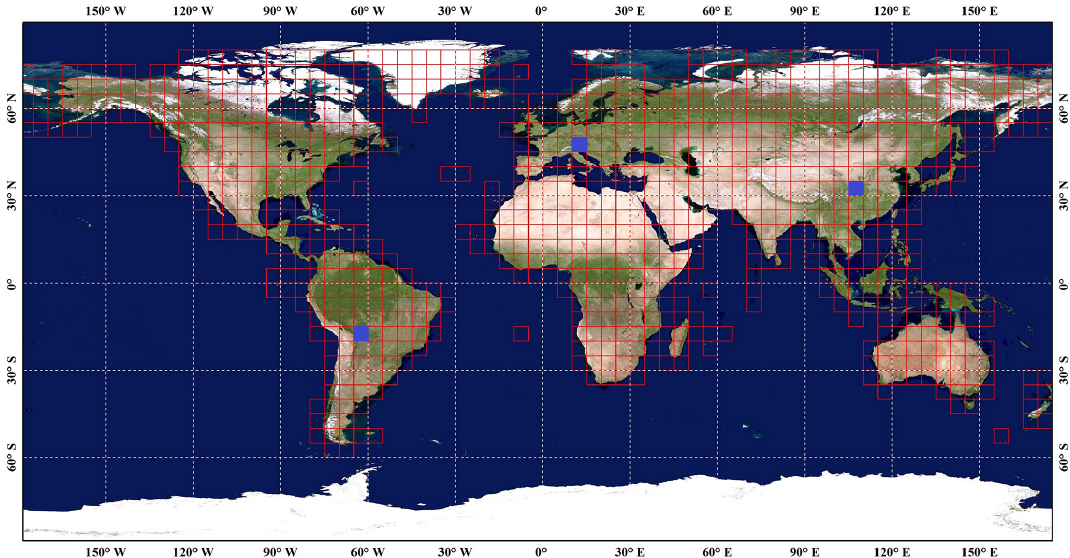
Figure 4. Overview of the 5 ◦ × 5 ◦ geographical tiles used for local adaptive modeling. Three blue rectangular tiles were used for comparing GLC_FCS30 with other land-cover products. The background imagery came from the National Aeronautics and Space Administration (https://visibleearth.nasa.gov, last access: 11 June 2021).